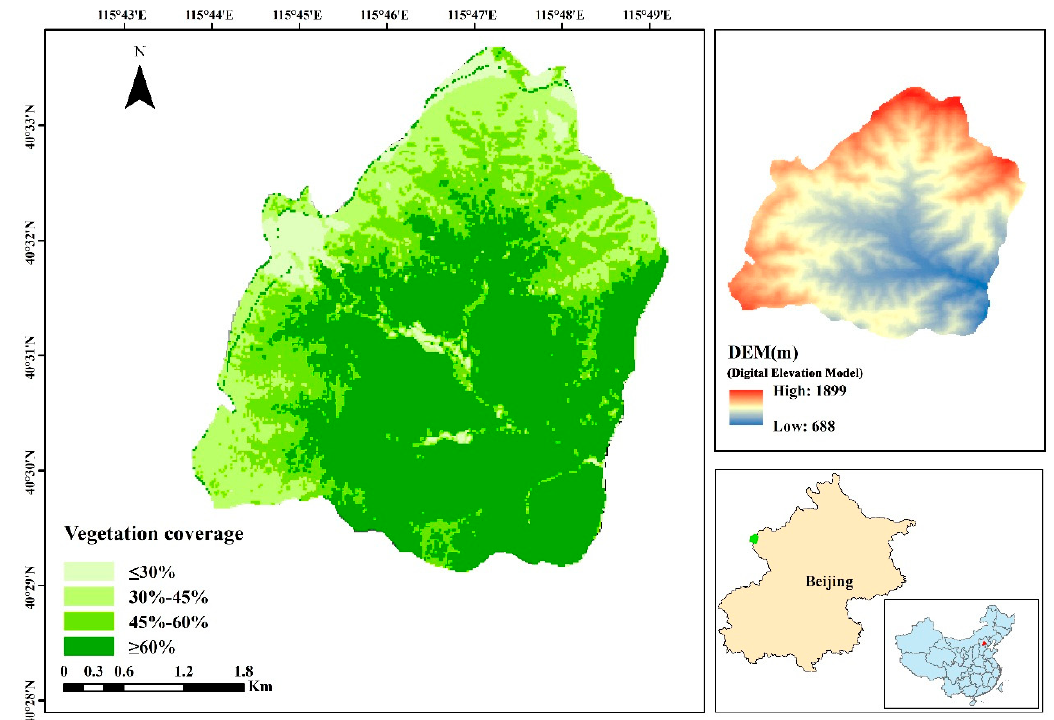
Figure 1. Geographical location, DEM (Digital Elevation Model) and vegetation coverage of the Songshan Nature Reserve.